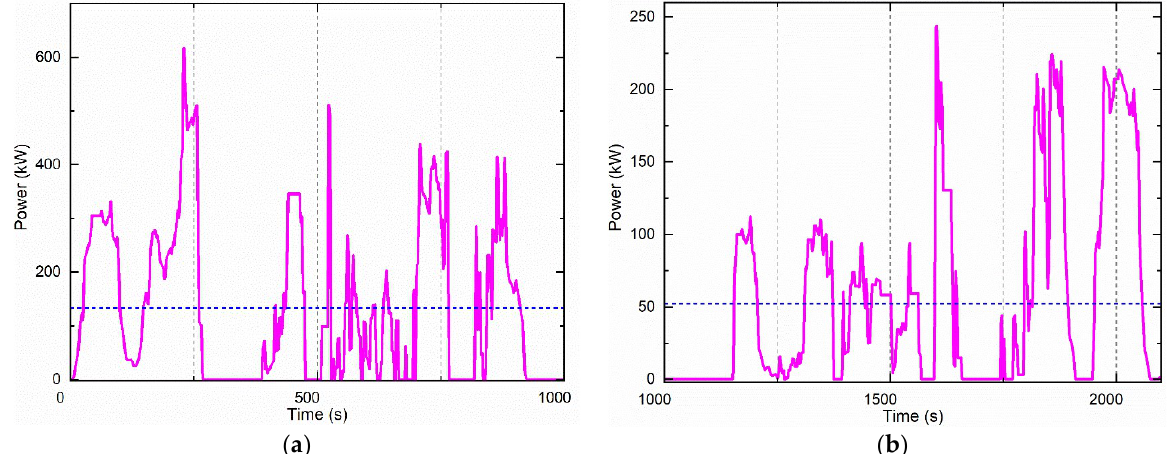
Figure 4. Typical real condition of the HMDTS. ( a ) real velocity in typical condition; ( b ) load mass in typical condition; ( c ) slope in typical condition.